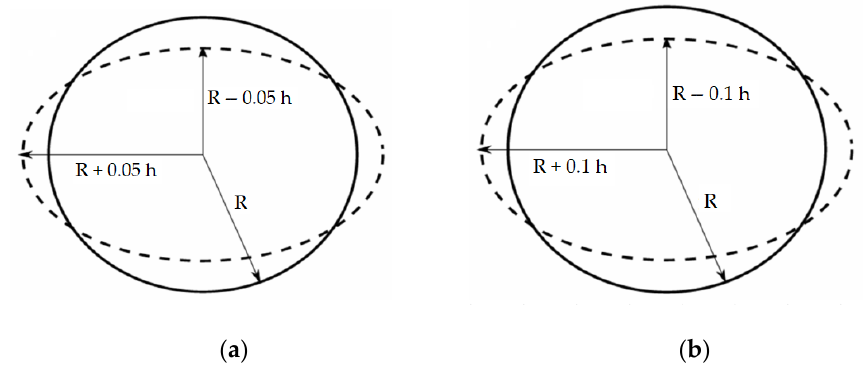
Figure 18. Maximum shell imperfections at the mid-section: ( a ) 5% and ( b ) 10% of the shell thickness.